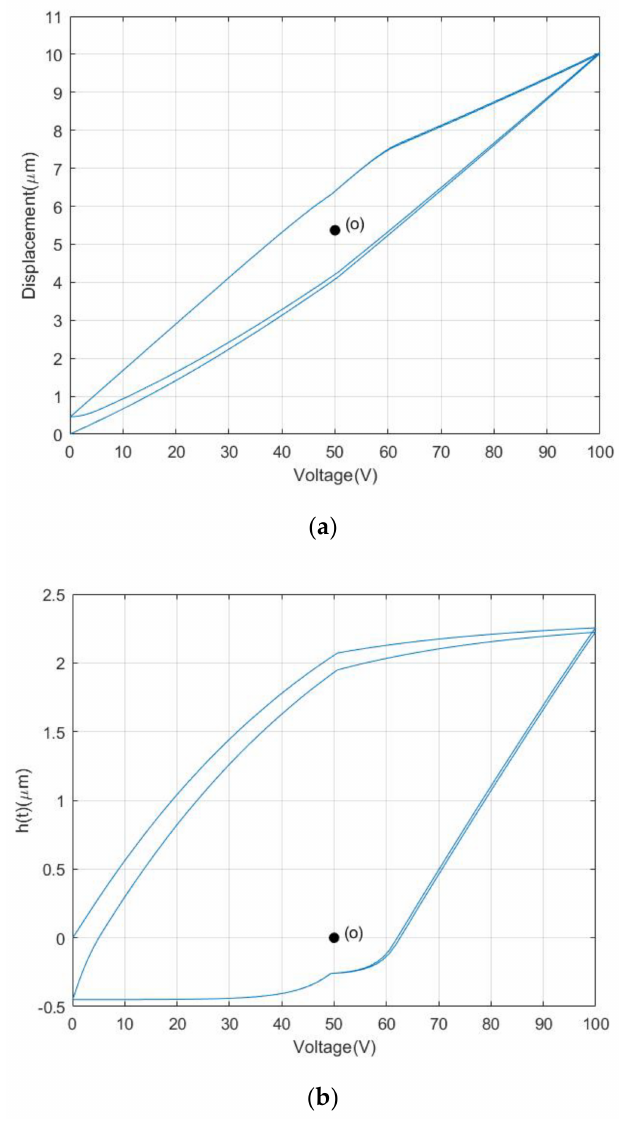
Figure 6. Output displacement and nonlinear components of MBW model. ( a ) Output displacement of MBW model. ( b ) Nonlinear component of MBW